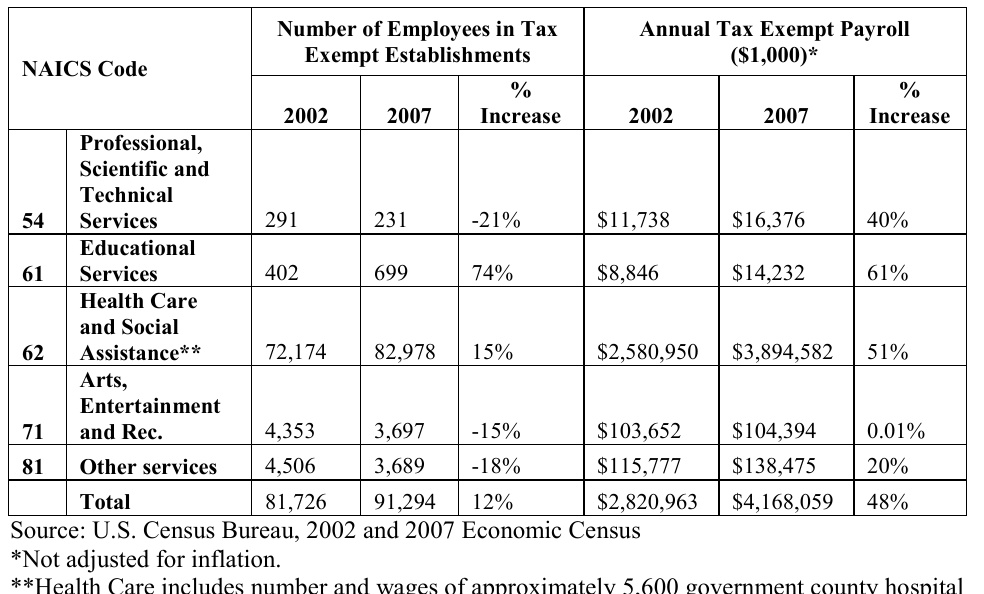
Table 3. Nonprofit Employment in Cuyahoga County, 2002 and 2007